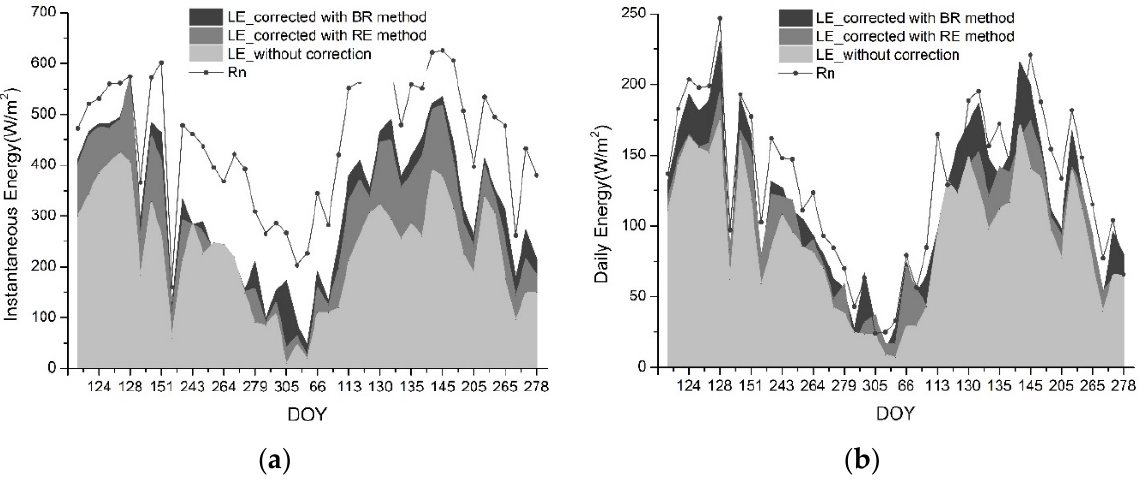
Figure 3. Time-series of LE and R n observations with and without energy imbalance corrections over the Yucheng site at ( a ) the instantaneous 10:30 scale and ( b ) the daily scale over 45 clear skies.